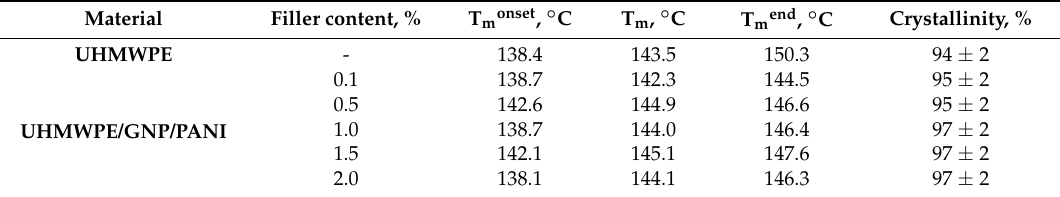
Table 3. DSC test results for the UHMWPE films ( ± the standard